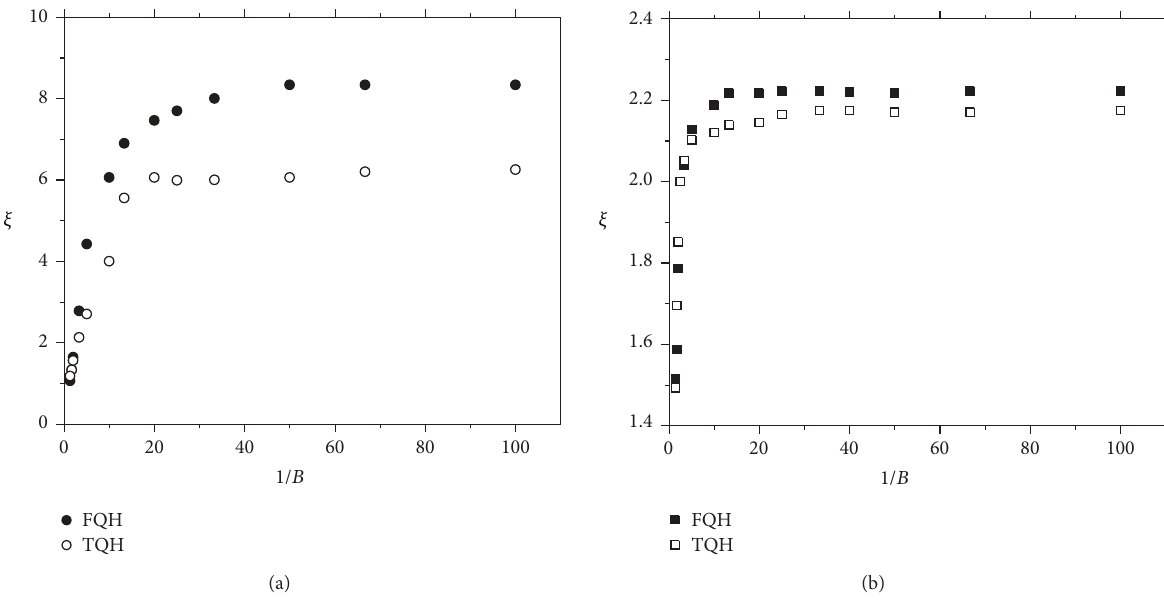
Figure 4: The characteristic length 𝜉 as a function of 𝐵 for (a) 𝑊 = 1 and (b) 𝑊 = 3 . In both figures 𝑝 = 0.1 , 𝑇 = 0.5 , and 𝐿 = 70 .